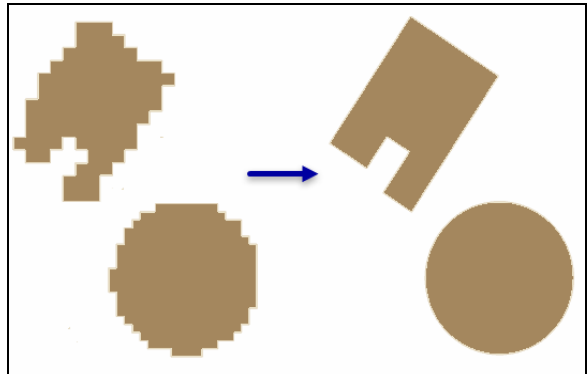
Figure 5. Effects of applying the dynamic polyline compression algorithm (Adapted from: https://goo.gl/9jrrRw)